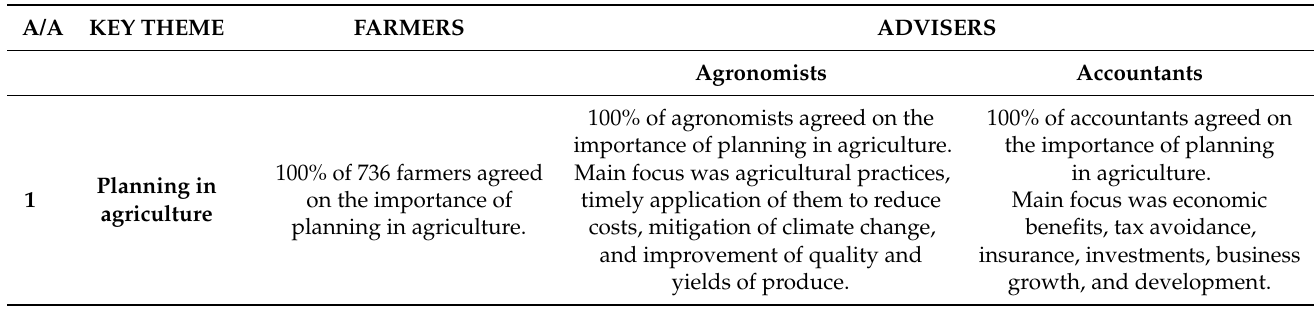
Table 3. Key themes of the content analysis and information drawn from